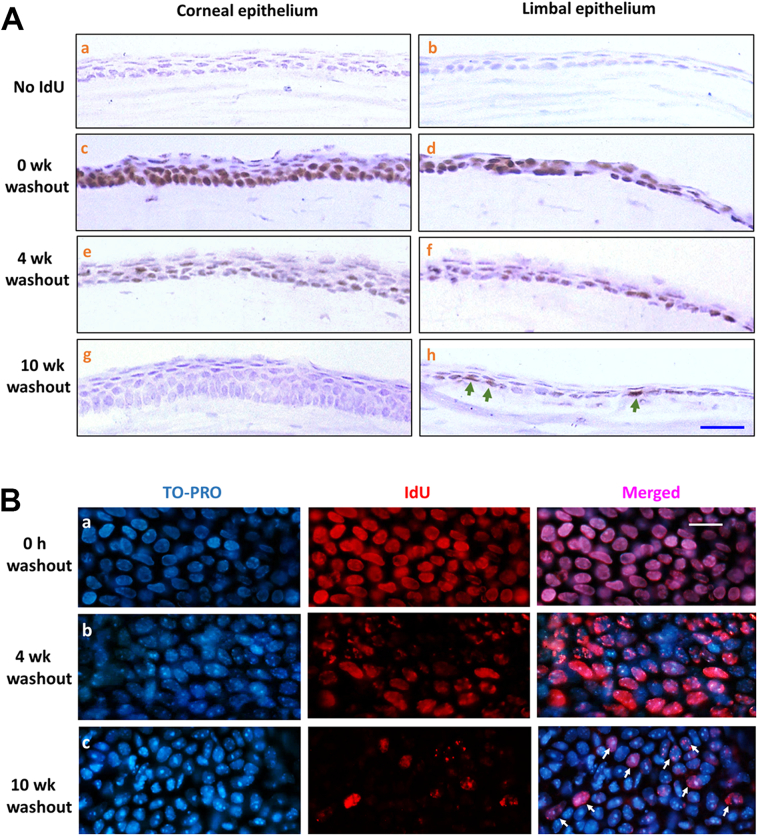
Location of IdU Label-retaining cells.Corneal and limbal tissues from adult (C57BL/6) mice exposed to long-term IdU treatment (30 days) followed by washout periods: 0 week, 4 weeks and 10 weeks. (A) Hematoxylin-stained cross-sections of corneal and limbal tissues. IdU visualized by immunostaining (brown). (a, b) No IdU-treatment (negative controls). (c, d) 0-week washout – all cells labelled. (e, f) 4-weeks washout. (g,h) IdU-label undetectable in the corneal epithelium after 10-weeks washout but ~25% of basal limbal epithelial cells retain IdU-label (green arrows). Scale bar = 20 μm. (B) IdU-immunostaining (red) of flat-mounted limbal epithelia after 30 days IdU labelling. TO-PRO3 (blue) nuclear stain. (a) 0-week washout shows IdU label in 100% of the cells. (b) 4-weeks washout. (c) 10-weeks washout period reveals ‘label-retaining cells’ indicated by white arrows. Scale bar = 10 μm. Abbreviations: wk., week; h, hours.